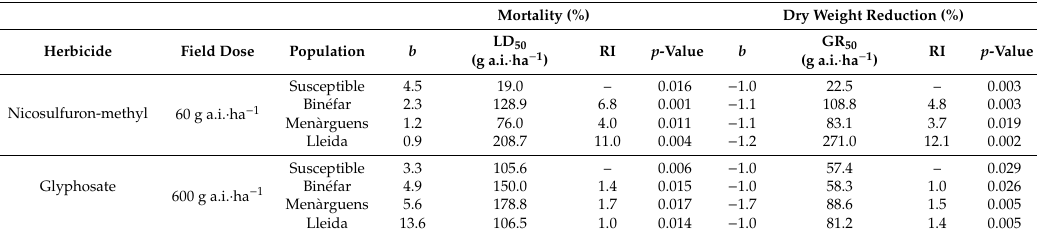
Table 3. Estimated slopes ( b ), plant mortality (LD 50 ) and growth reduction of plants (GR 50 ), p -values (level of significance of curves fitting) and resistance index (RI) values for mortality (%) and dry weight reduction (%) to nicosulfuron-methyl and glyphosate for several Amaranthus palmeri populations in 2018: three from Spain and one susceptible (S) standard from US.